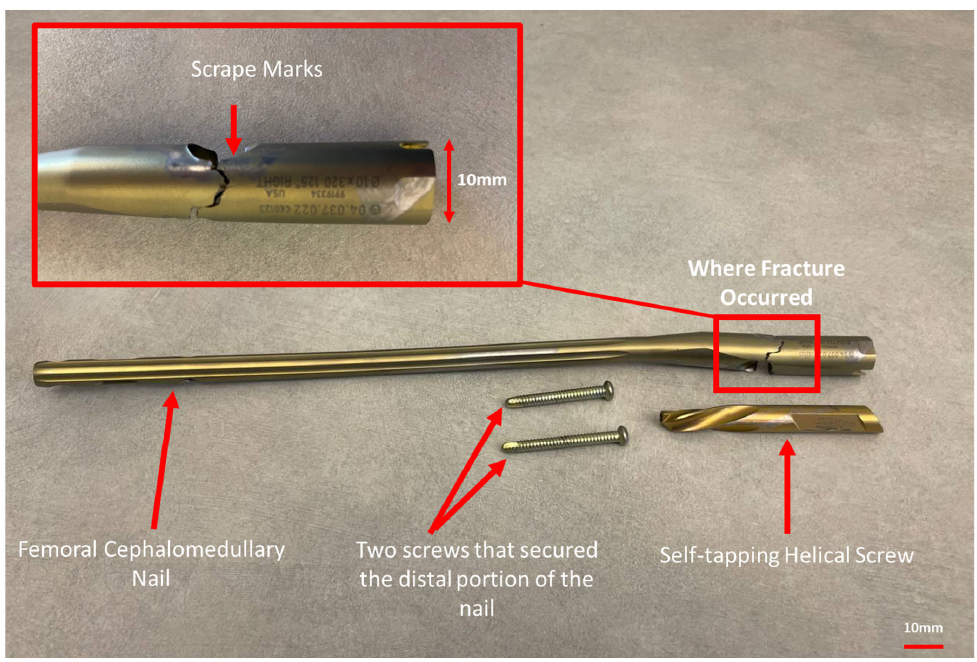
Figure 2. The as ‐ received femoral cephalomedullay nail showing the femoral cephalomedullary